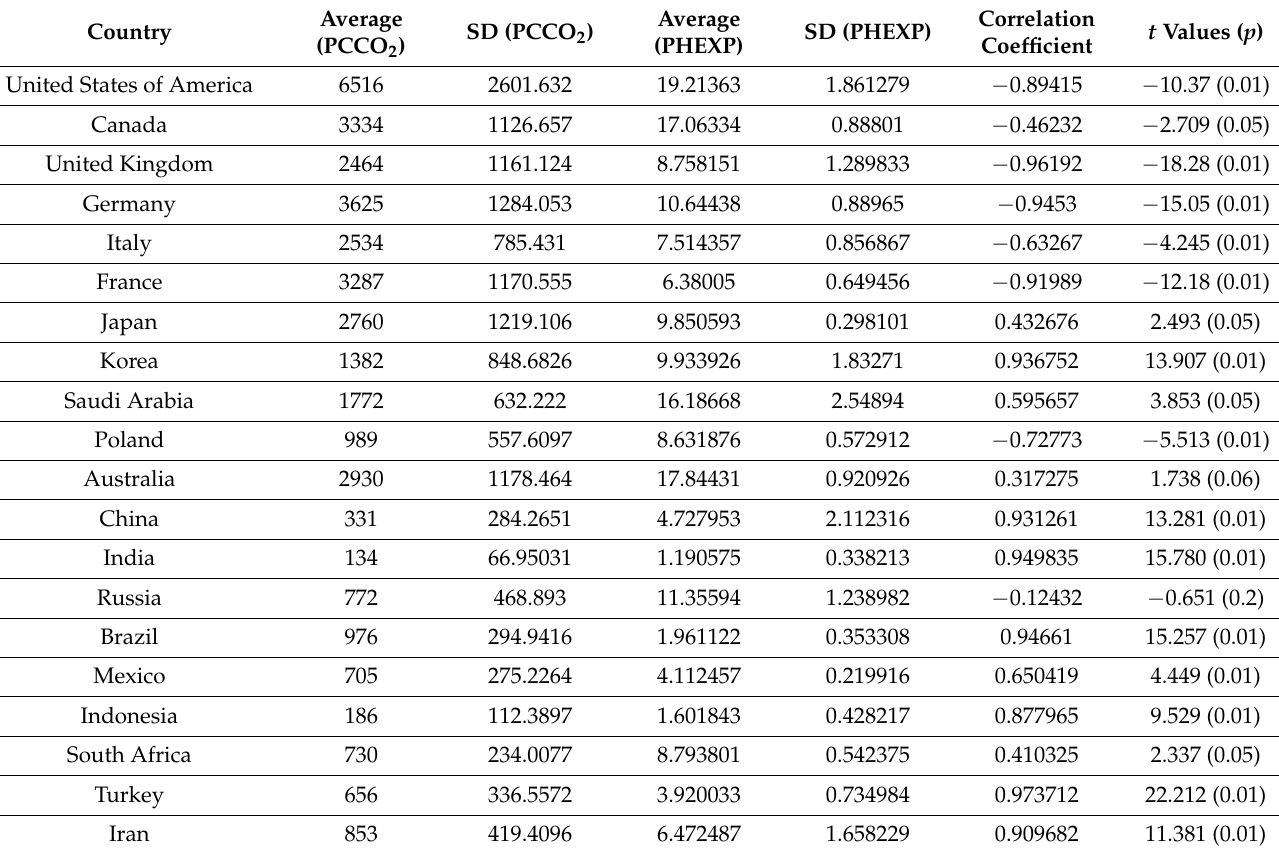
Table 1. Descriptive statistics. Source: Author’s own calculations.